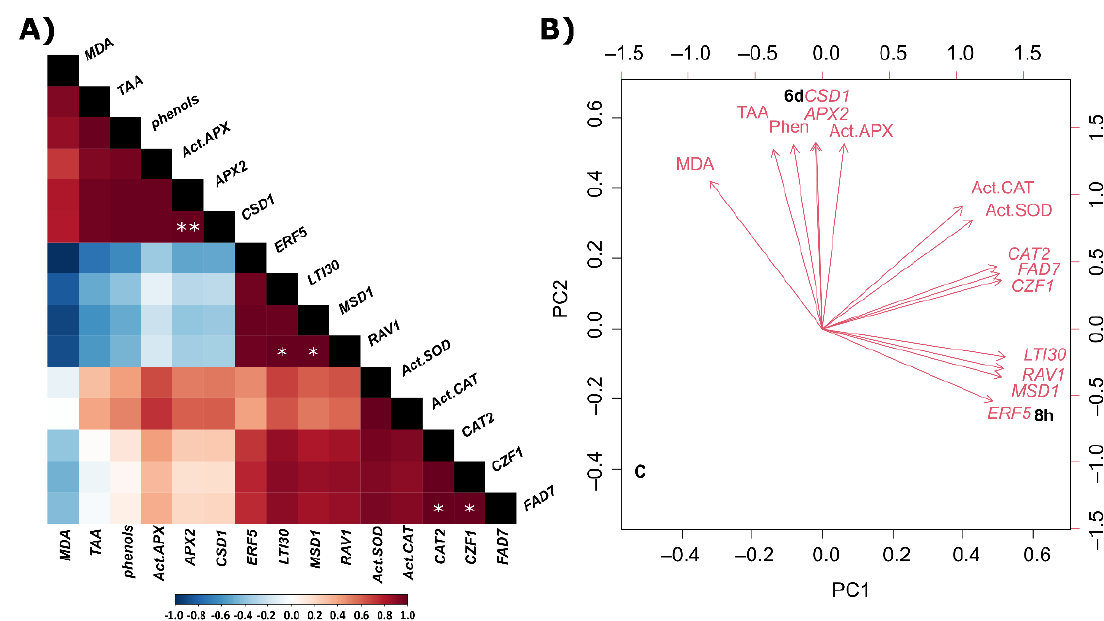
Figure 4. Correlation and PCA of the data. ( A ) Pearson correlation coefficients indicate negative (blue) or positive (red) correlations. * p < 0.05; ** p < 0.01.; ( B ) PCA biplot of the data in Q. suber . C—control, 8 h—8 h after NaCl treatment, and 6 d—6 days after NaCl treatment.